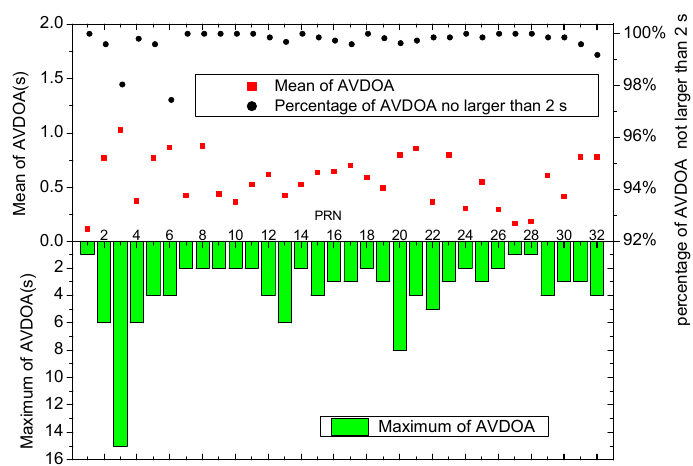
Figure 2. Comparison of ORTM- and ARTA-derived MRT estimates. AVDOA is short for “the absolute value of the difference between ORTM- and ARTA-derived MRT”. The y -axis, showing “percentage of AVDOA no larger than 2 s”, is on the right side of the upper panel.